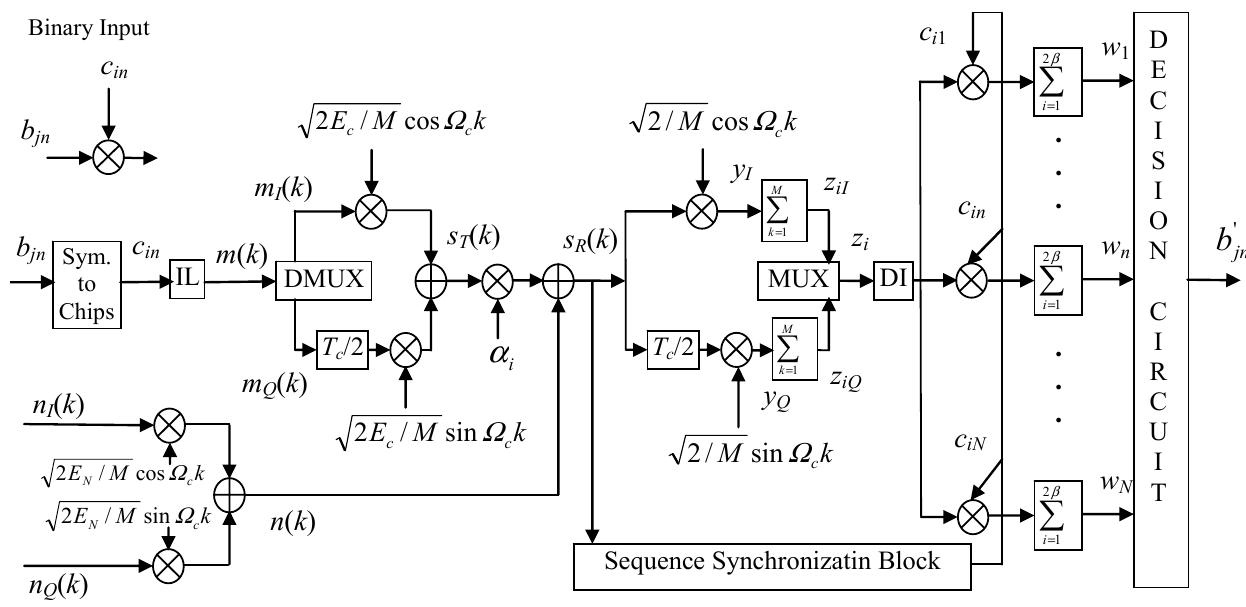
Figure 1. Block schematic of communication